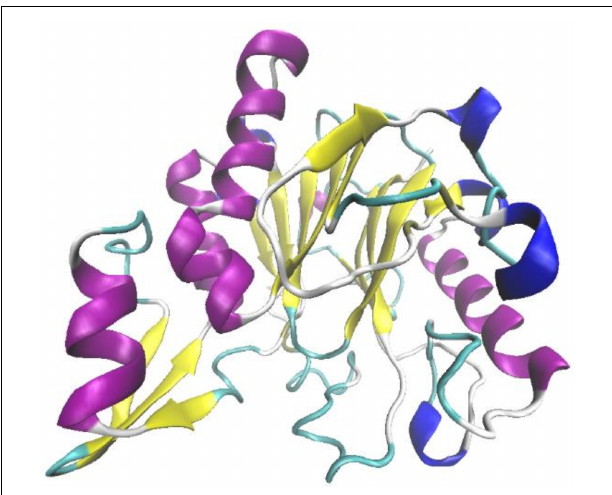
FIGURE 1 | The prediction on tertiary structure of OhLac using Swiss-Model.